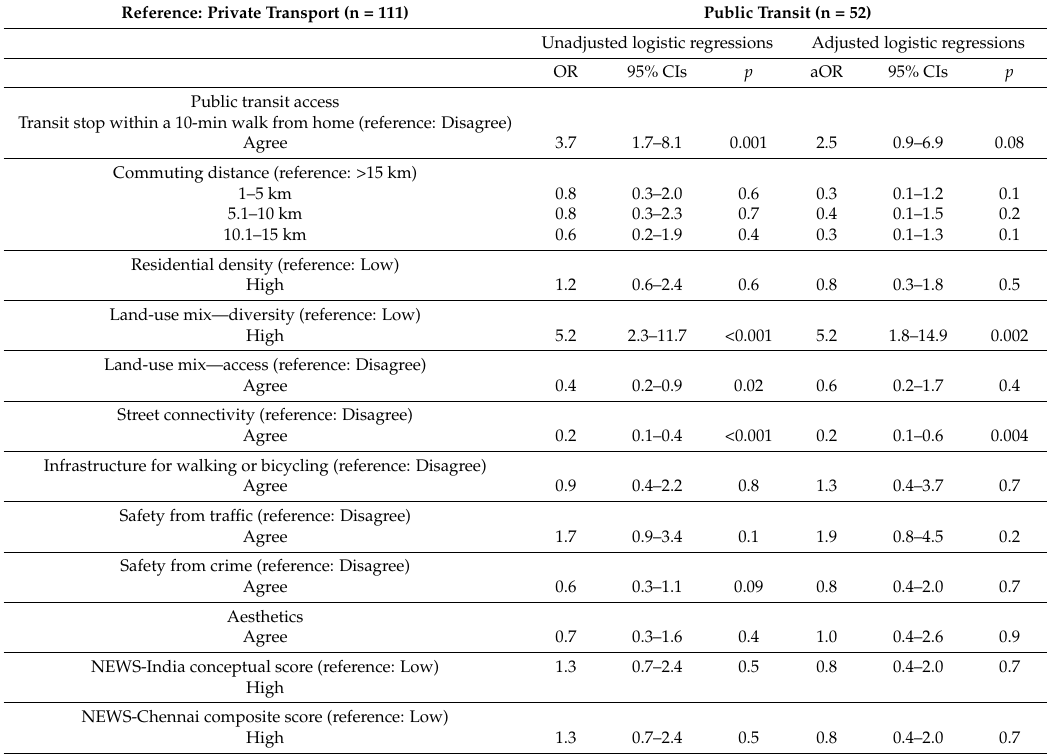
Table 4. Crude and adjusted odds ratios examining the associations between public vs. private transport and home neighborhood supports in Chennai, India (Model